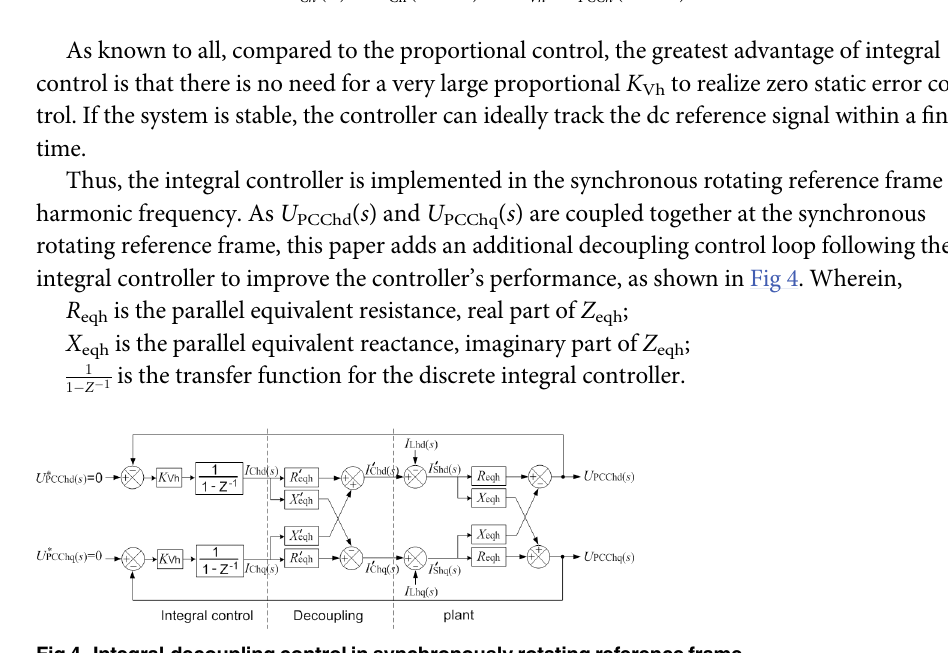
Fig 4. Integral-decoupling control in synchronously rotating reference